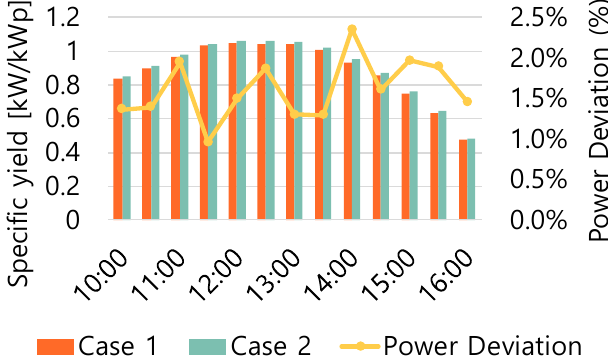
Figure 3. Specific yield for each case and power deviation.